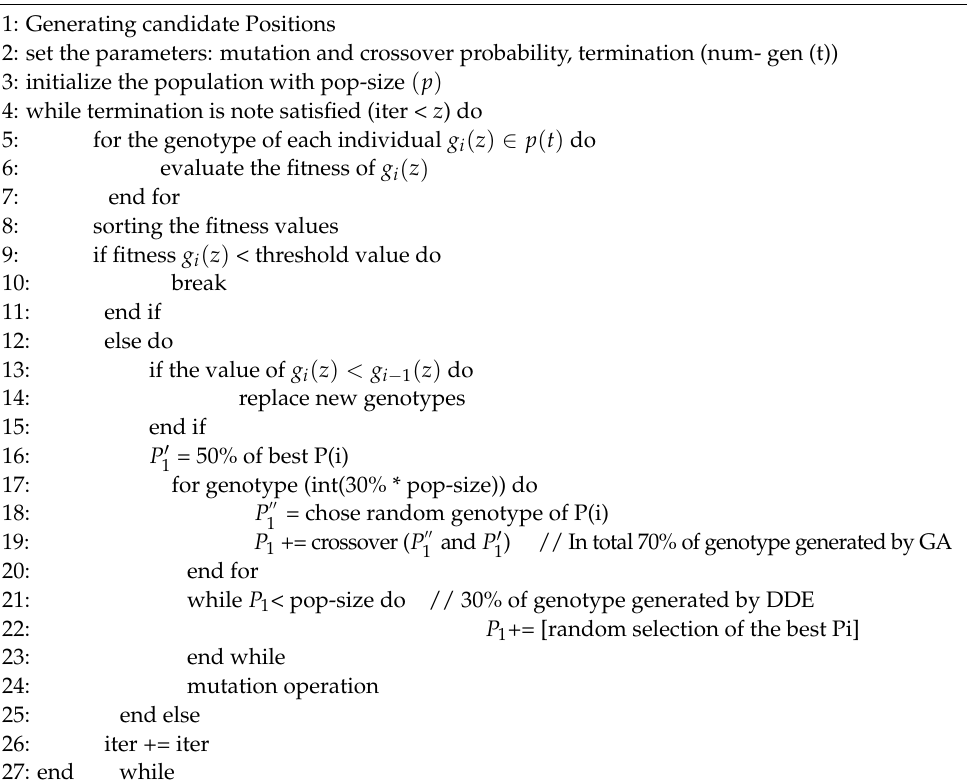
Algorithm 2. Optimization